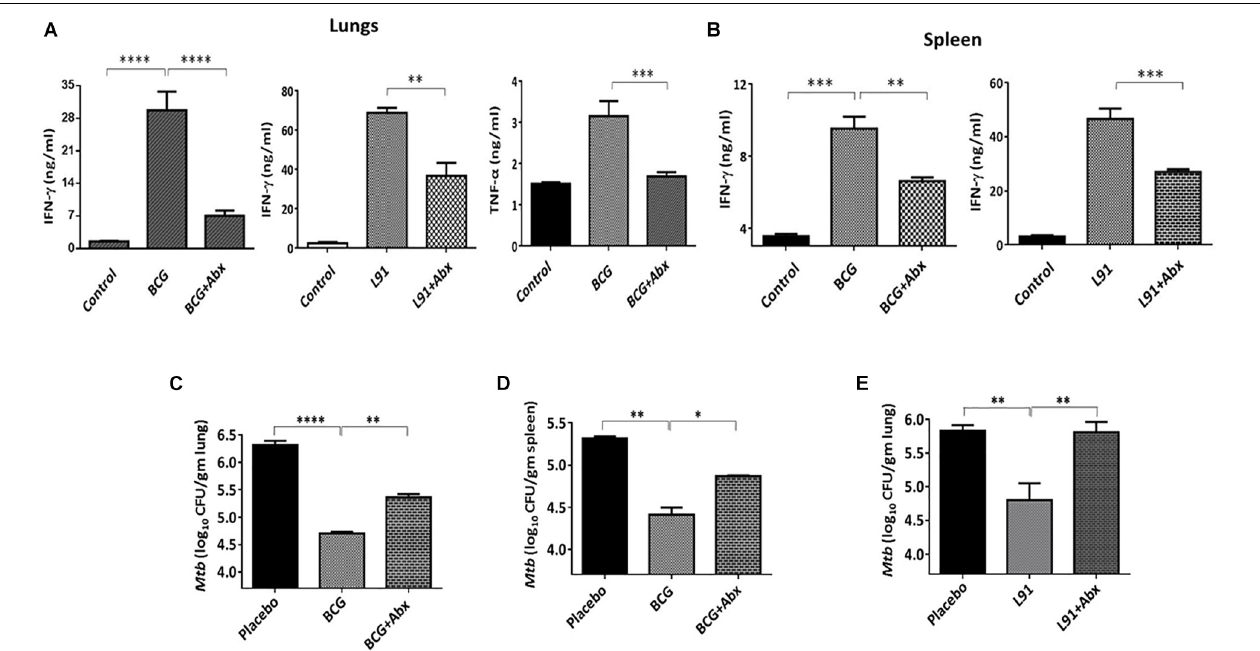
FIGURE 5 | Gut dysbiosis impairs the efficacy of vaccines by inhibiting the differentiation of T cells. The cells isolated from the lungs and spleen of Abx treated and BCG vaccinated mice were cultured and in- vitro stimulated with Mtb- PPD for 48 h. Later, the culture supernatant was collected and T cell differentiation was monitored by estimating the yield of IFN- γ and TNF- α by ELISA in the cells isolated from (A) lungs and (B) spleen. The Mtb load in the (C,E) lungs and (D) spleen was enumerated by CFUs. Data shown as mean ± SEM are representative of two independent experiments ( n = 3–4 animals/group). * p < 0.05, ** p < 0.01, *** p < 0.001, and **** p <